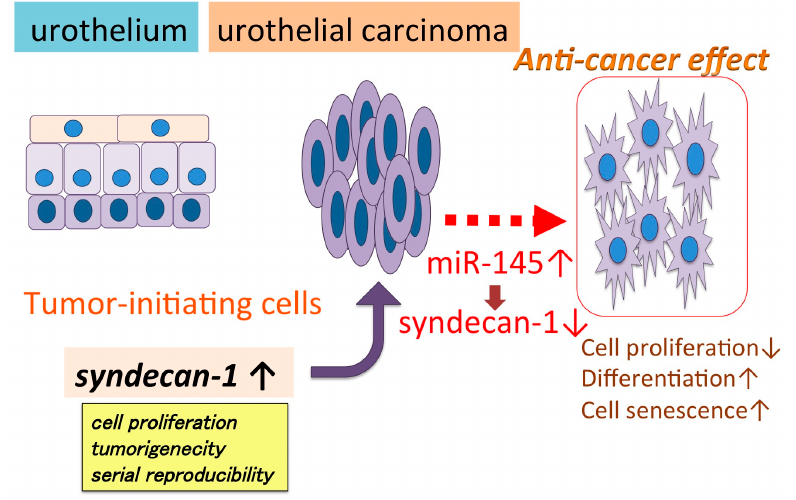
Figure 1. miR-145 regulates cell proliferation, differentiation, and senescence by regulating syndecan-1 in urothelial carcinoma cells. miR-145 and syndecan-1, a putative direct target of miR-145, control the expression of cell differentiation markers [70].